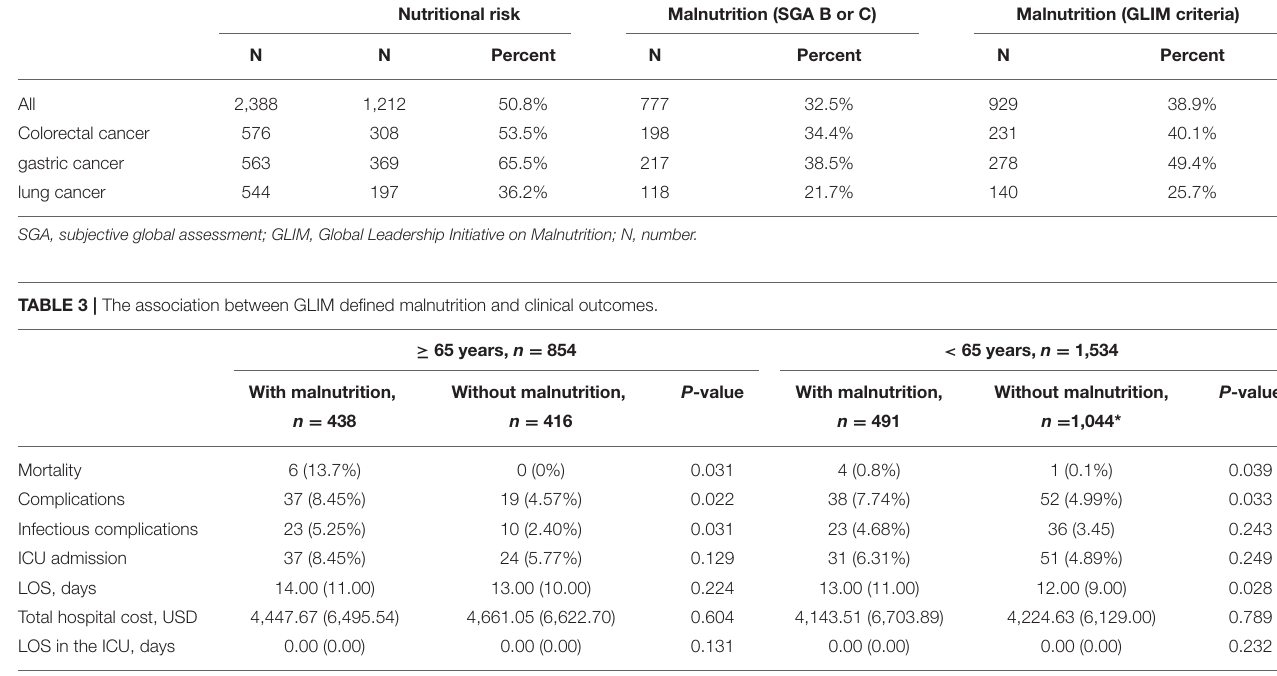
TABLE 2 | The nutritional status of patients with cancer grouped by disease type. Nutritional risk Malnutrition (SGA B or C)